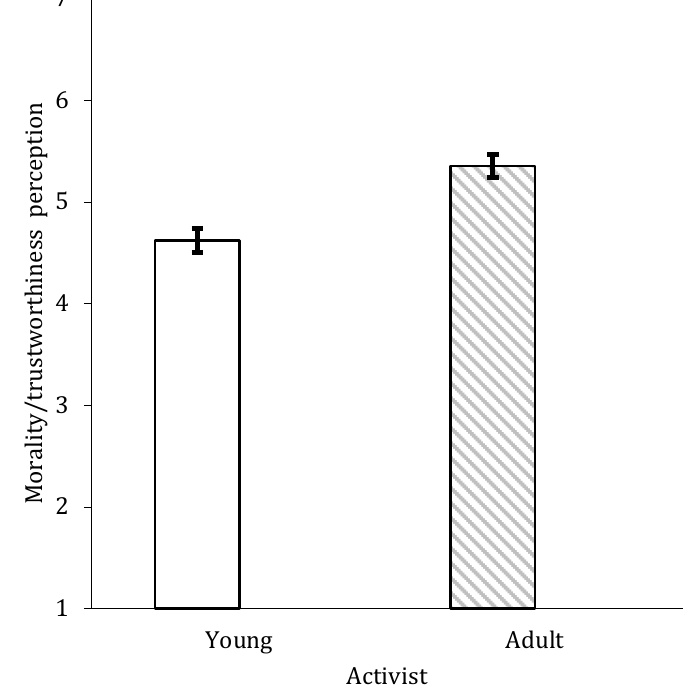
Figure 4. Means and standard errors regarding morality/trustworthiness by experimental conditions.